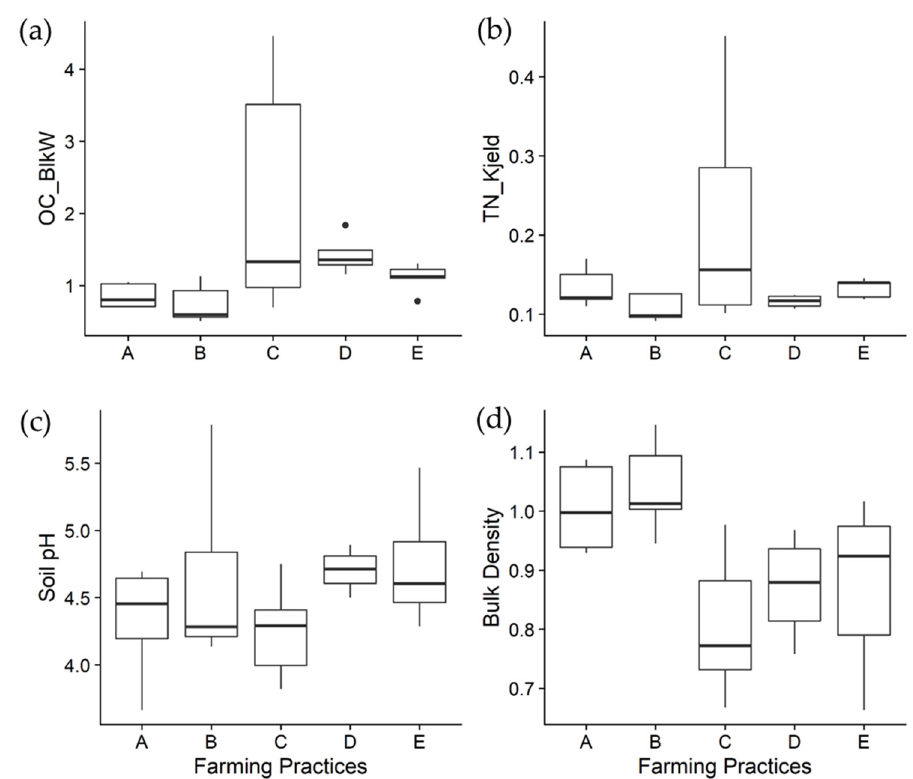
Figure 5. Boxplots for SOC ( a ), TN ( b ), soil pH ( c ), and BD ( d ) among different farming practices in Kilombero valley. Letters on the X-axis denote: A = traditional flood irrigation (rainfed) without intensification of rice farming; B = traditional flooding (rainfed) with rice intensification (SRI); C = AWD farming practice involving SRI with one cropping season; D = abandoned fields; and E = AWD farming practice involving SRI with two cropping seasons.